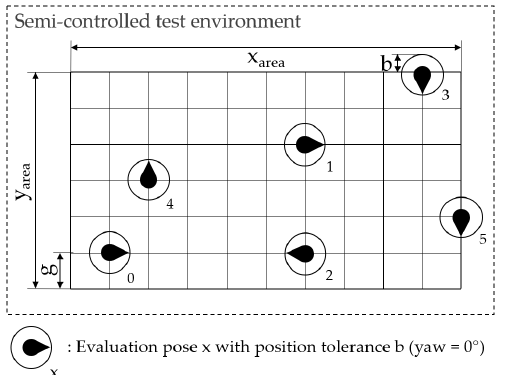
Figure 7. Random grid-based sampled evaluation poses. The arrow points into the heading directions of an evaluation